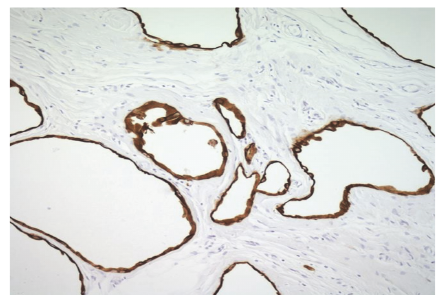
Figure 4: Cyst lined by cytokeratin AE1/AE3 positive